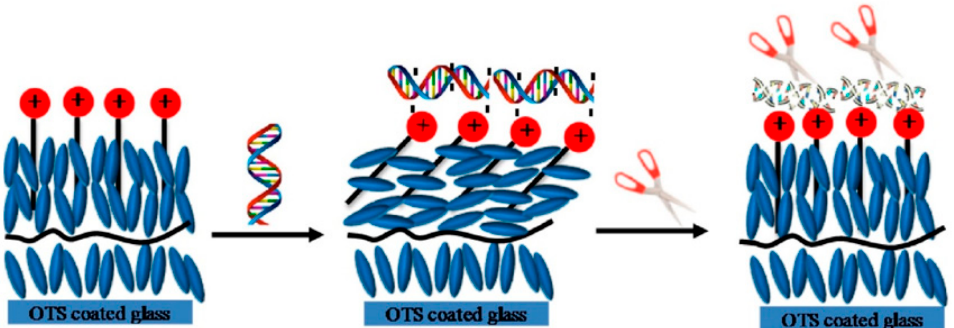
Figure 18. Model of the TEM DTAB / DNA grid cell and the myricetin detection mechanism. Reprinted from ref. [144] with permission of Elsevier.